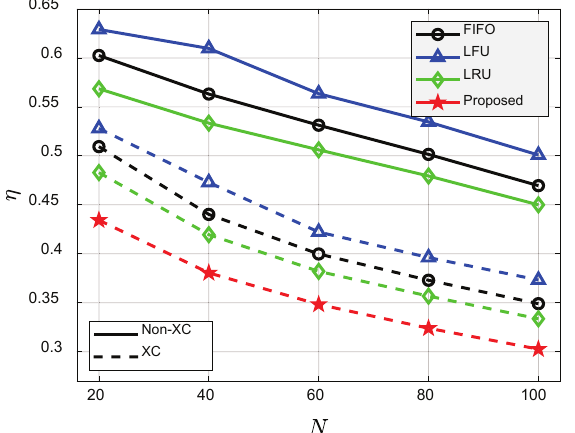
Figure 8. Average number of required transmissions for various N ’s. p = 0.001, ρ = 0.5, V = 100, C = 20, K = 10, and β =